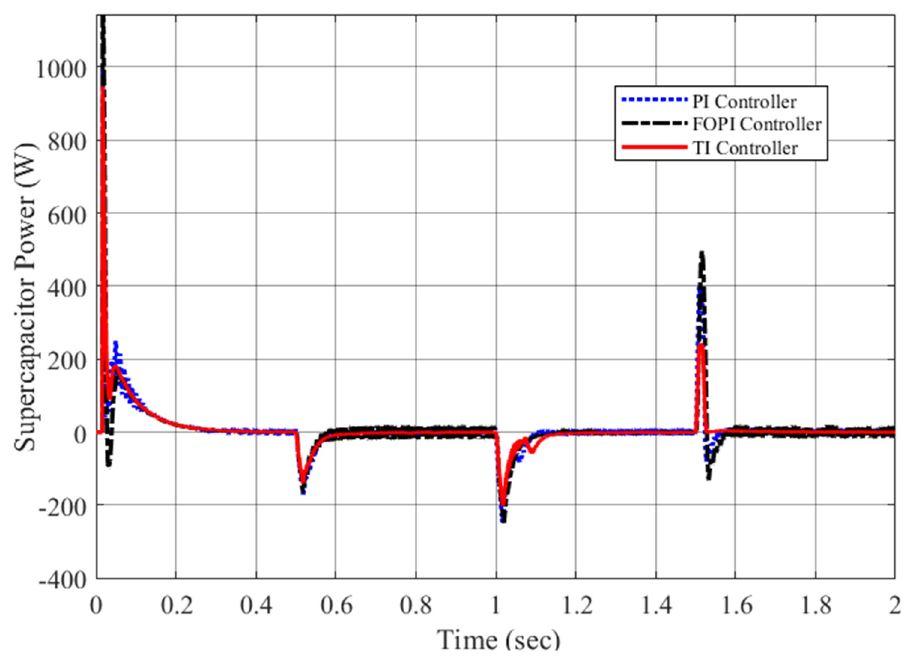
Figure 11. Response of the supercapacitor power with varying irradiance and load conditions.